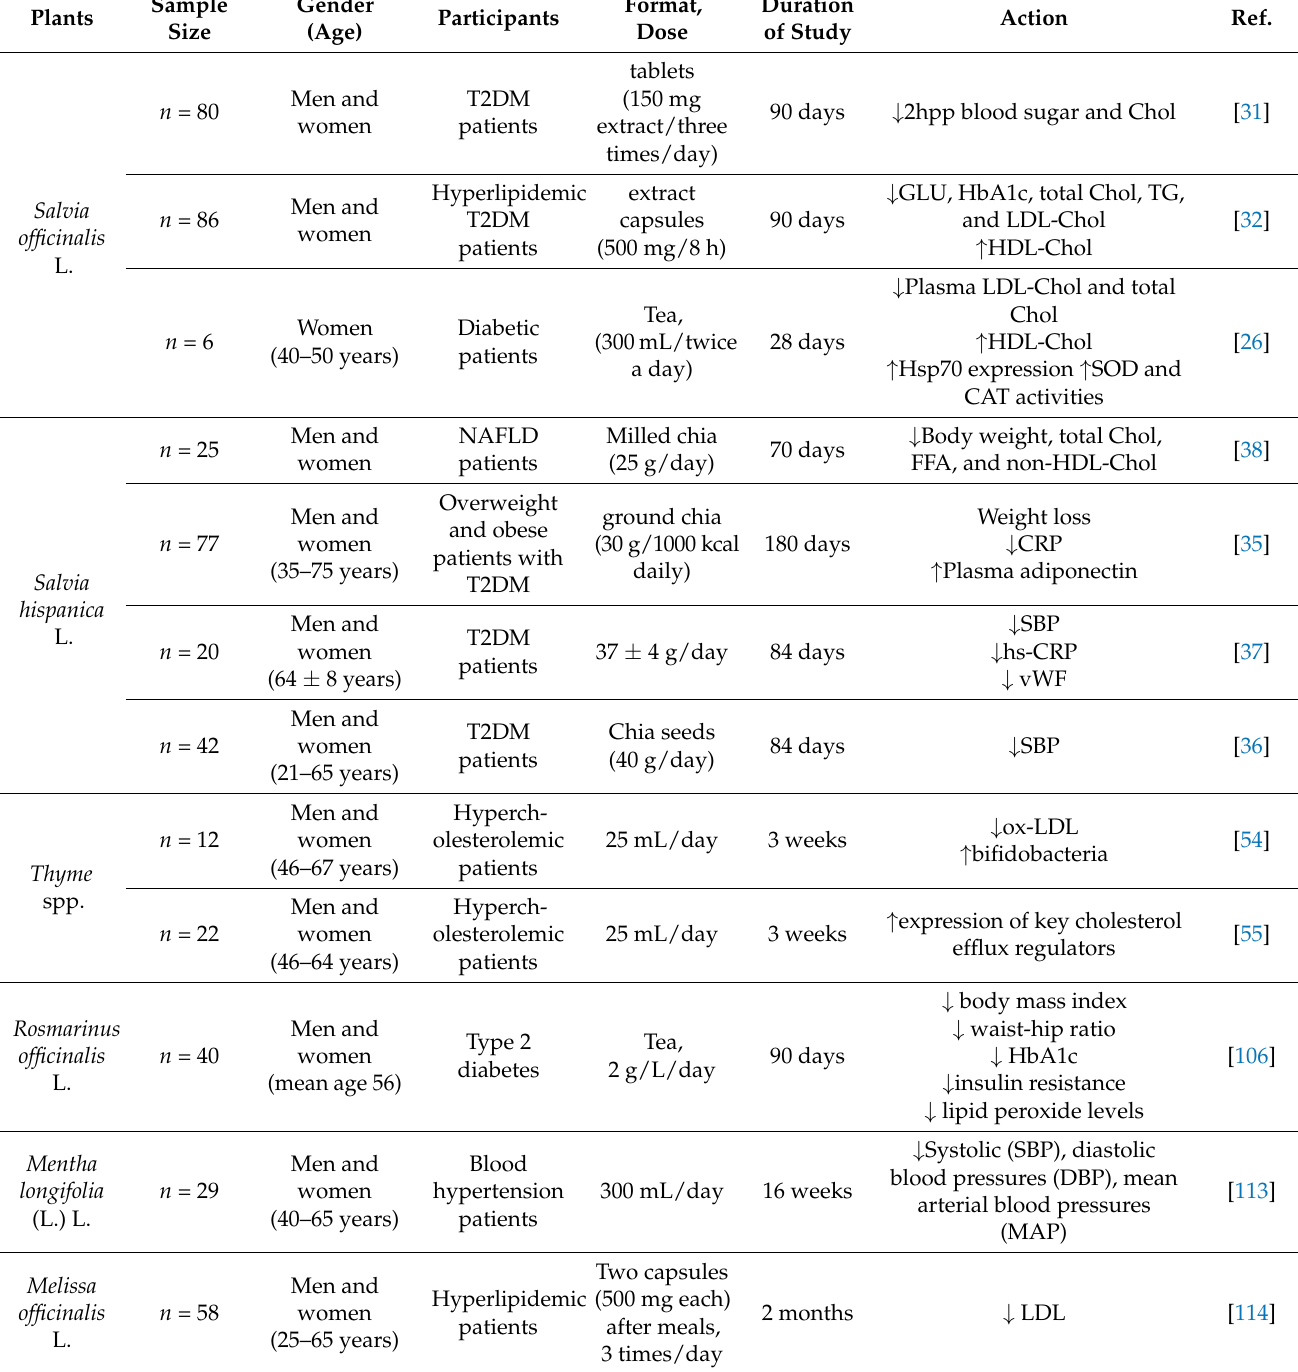
Table 3. Main clinical controlled trials on the intake of Lamiaceae plant